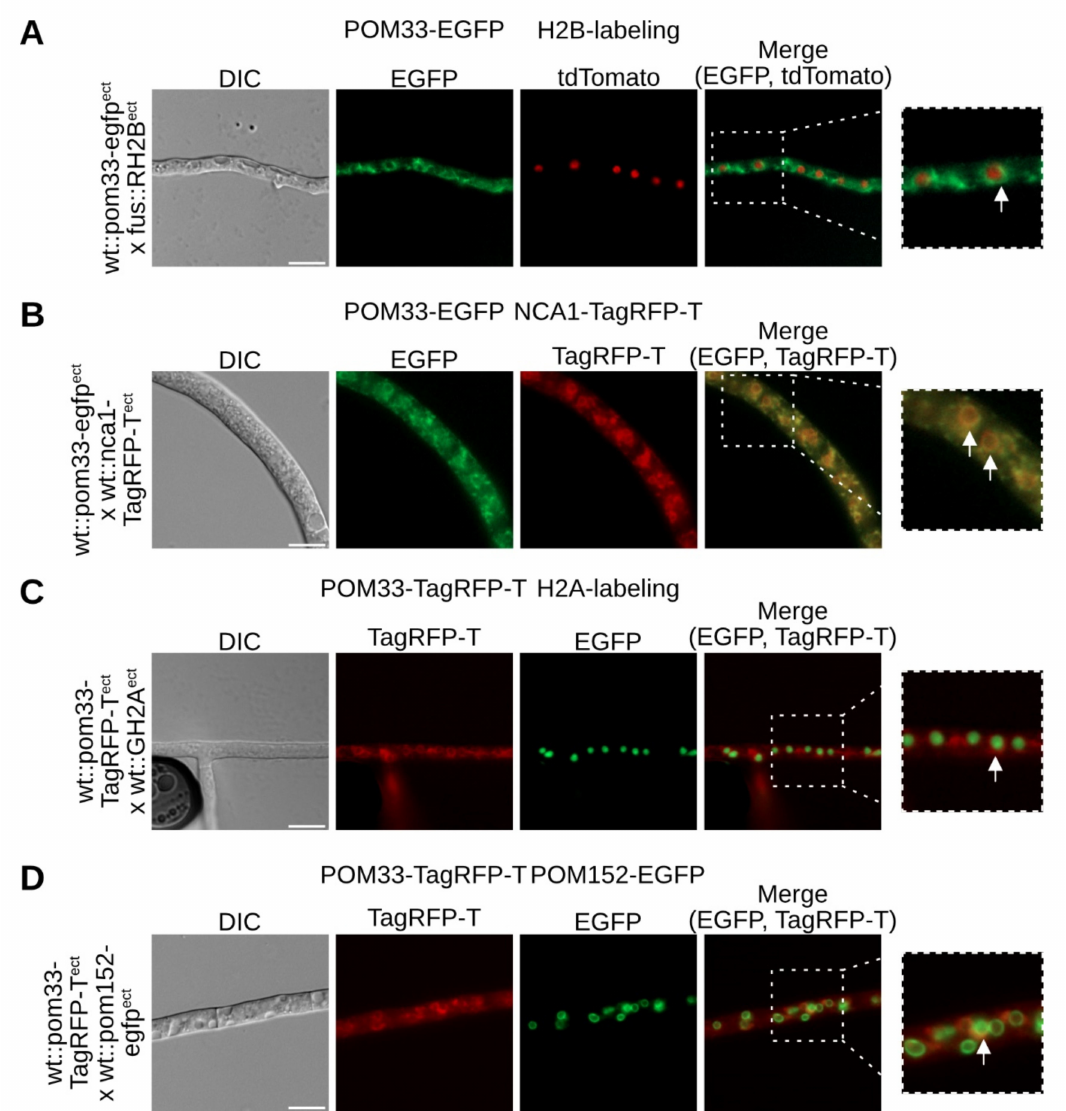
Figure 2. Co-localization of POM33 and marker proteins in S. macrospora wt using different fluorescence tags. S. macrospora wt expressing either POM33-EGFP or POM33-TagRFP-T was crossed with S. macrospora strains expressing marker proteins for the nucleus, endoplasmic reticulum (ER) and the nuclear envelope or the wt strain was co-transformed. Fluorescence microscopy was performed to visualize co-localization of the fusion proteins. ( A ) S. macrospora wt expressing POM33-EGFP was crossed with the fus1-1 strain expressing histone 2B labeled with tdTomato (RH2B). White arrow indicates localization of POM33-EGFP around the nucleus. ( B ) S. macrospora wt strains expressing POM33-EGFP and NCA1-TagRFP-T were crossed and co-localization of both proteins resulted in a yellow fluorescence signal is shown by the white arrows in the merged zoom-in picture. ( C ) S. macrospora wt expressing POM33-TagRFP-T and histone 2A tagged with EGFP (GH2A) were crossed to show localization of POM33 around the nucleus, independent of the fluorescence tag (white arrow in the merged zoom-in). ( D ) Partial co-localization of POM33-TagRFP-T with POM152-EGFP in S. macrospora wt (indicated by the white arrow). Scale bars = 10 µ m. DIC, differential interference contrast. Detailed two-fold enlargements of the merge pictures are indicated with a dashed frame and shown at the right